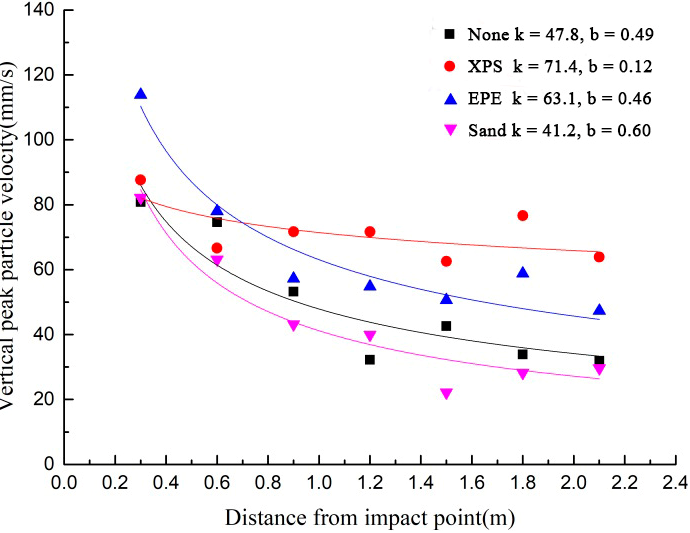
Figure 14. Dynamic response of double-layer plate with different filling materials.